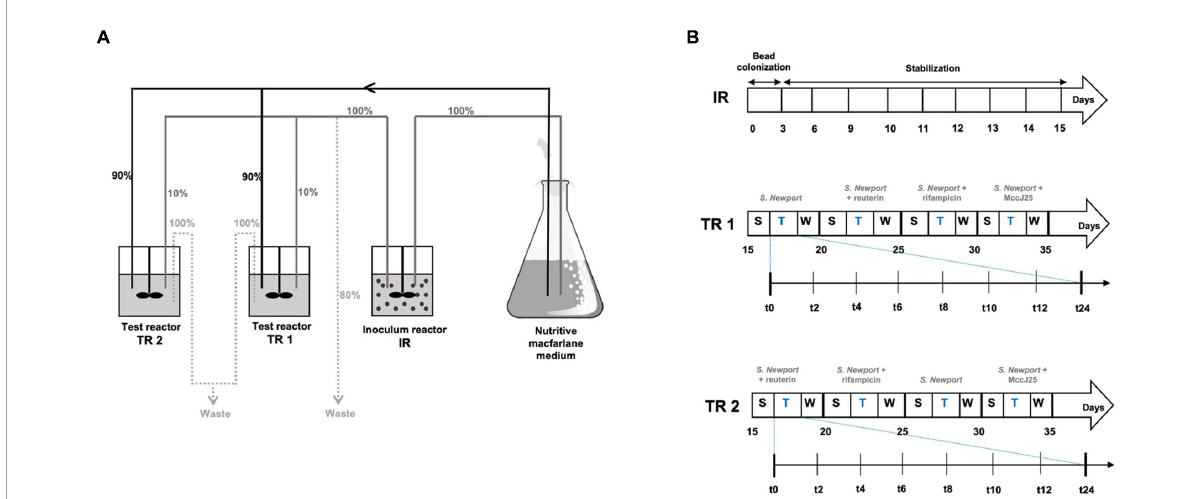
FIGURE1 Experimental set-up of the continuous fermentation experiment. (A) Overview of the PolyFermS model composed of one inoculum reactor and two test reactors and experimental plan used: relative flow rates are indicated in%. IR: inoculum reactor containing pig fecal bacteria immobilized in gel beads (30% v/v); TR1, TR2: test bioreactors; S: stabilization period; T: treatment period; W: wash period. (B) Experimental treatment and samples collection